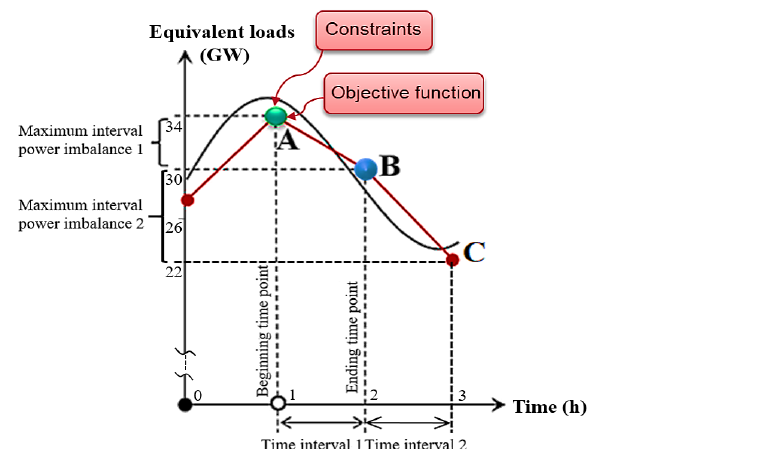
Figure 1. Traditional optimal power flow, where the objective function and constraints are solved on the beginning time point A, and assumed the optimal solution to meet all system constraints until the dispatch is adjusted at point B during the time interval